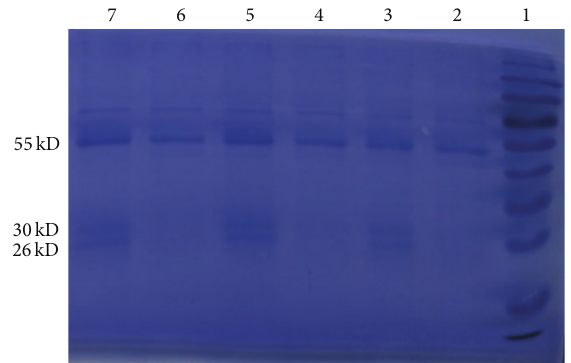
Table 1: Patient demographics and